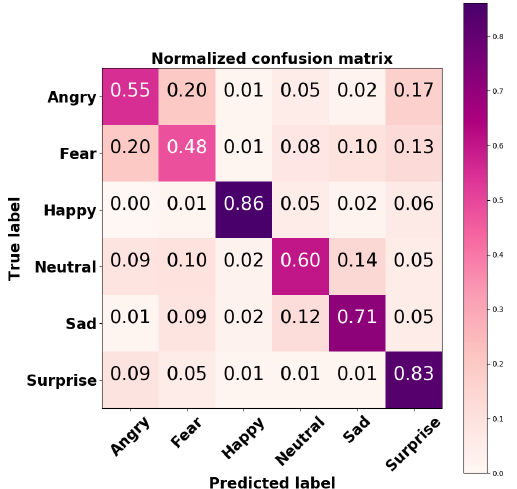
Figure 9. Normalized confusion matrix of the CNN-based FER model tested on the FER2013 dataset.